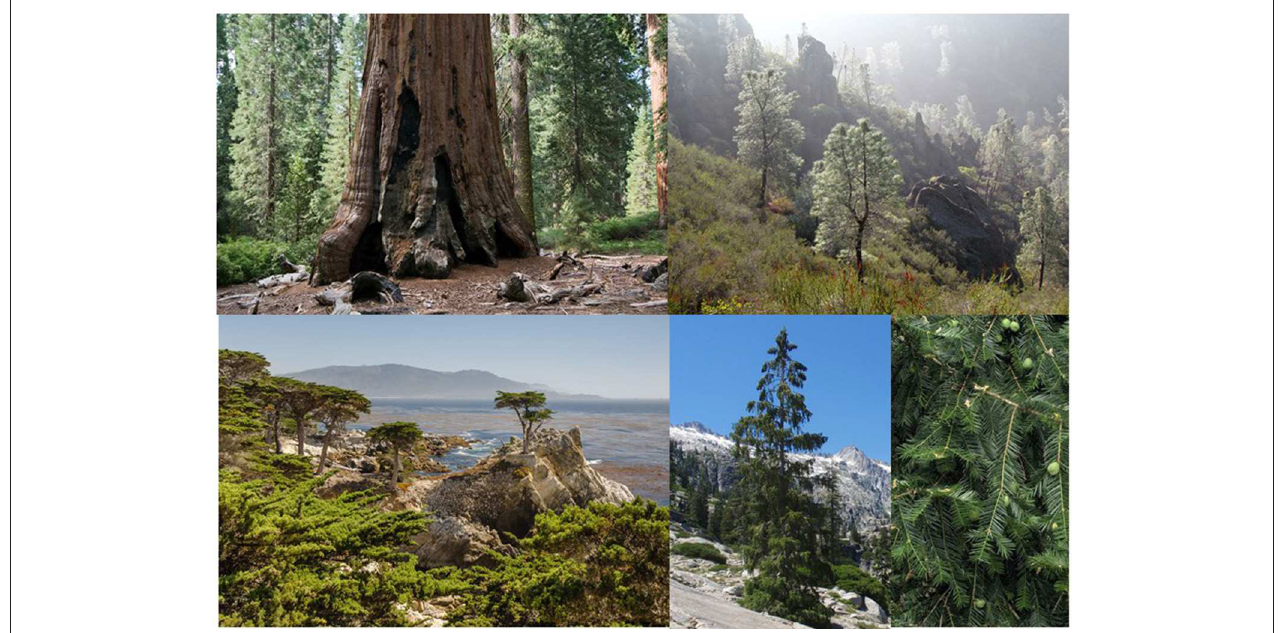
FIGURE 3 | California endemic conifers. Sequoiadendron giganteum , Cupressaceae (photo by Matthew Fong); Pinus sabiniana , Pinaceae (photo by chuck b.); Hesperocyparis macrocarpa , Cupressaceae (photo by Tuxyso); Picea breweriana, Pinaceae (photo by Tom Hilton); Torreya californica , Taxaceae (photo by John Rusk).